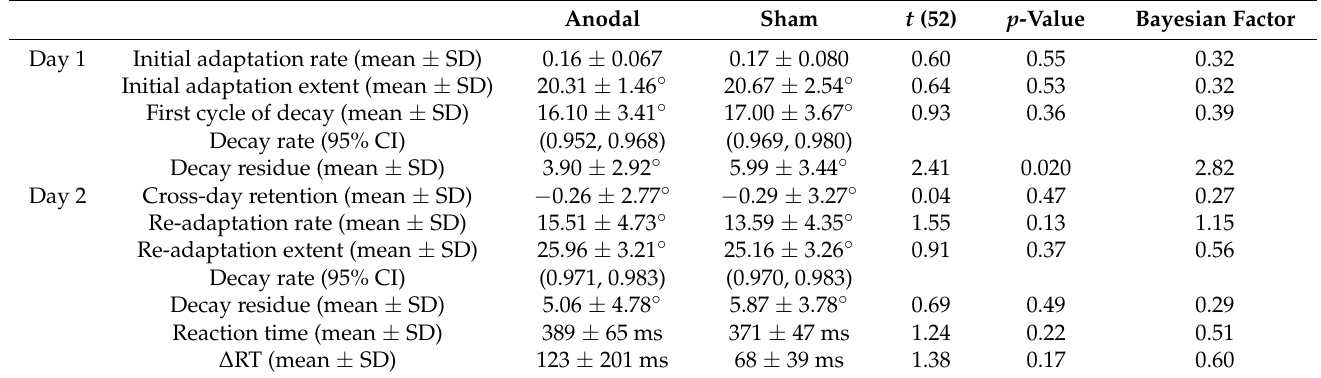
Table 3. Group comparisons of metrics for implicit adaptation in Experiment 3. Anodal Sham t (52) p -Value Bayesian